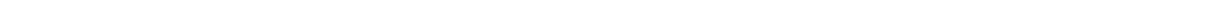
Fig. 1 T. brucei infection disrupts circadian activity and body temperature. a , b Schematic representation of infection progression when animals are ( a ) infected or ( b ) infected and treated with the anti-trypanosome drug suramin. c Representative actograms of daily wheel-running activity of control and infected mice in light – dark cycles. The record is double-plotted so that 48 h are shown for each horizontal trace. Black daily histograms represent locomotor activity. For the fi rst seven days, the animals were housed in an LD12:12 h cycle, denoted by the bar above the record. The animals were transferred to DD conditions for 10 days, as indicated by the horizontal line to the right of the record and shaded gray. After these LD and DD intervals, animals were transferred back into LD and either infected or injected with vehicle. The red and orange lines near the actogram refers to the infection progression represented in panel a . d Total daily activity levels of control ( n = 6) and infected ( n = 14) mice. e Representative actograms of daily wheel- running activity of animals treated with suramin. The red and orange lines near the actogram refers to the infection progression represented in panel b . f Total daily and g relative rest-period activity levels of control ( n = 6) and infected ( n = 14) mice considering the whole infection time and only after day 50 post-infection. Error bars show mean ± s.e.m; * p < 0.05, ** p < 0.01, *** p < 0.001 tested with Mann – Whitney test in panels d , f , and g . h Representative plots of core body temperature of control and infected mice (suramin-treated) in light – dark cycles. i Zoom-in temperature plots showing the fever-like period after infection and the later period of temperature shift to daytime. j Amplitude of circadian temperature oscillation in control ( n = 5) and infected ( n = 7) mice. Error bars show mean ± s.e.m.; *adjusted p < 0.05, ** p < 0.01, *** p < 0.001, FDR method Benjamini – Hochberg. k Absolute temperature measurement for a representative control and an infected mouse. T.b. orange dotted line represents infection with trypanosomes and S, blue dotted line represents suramin